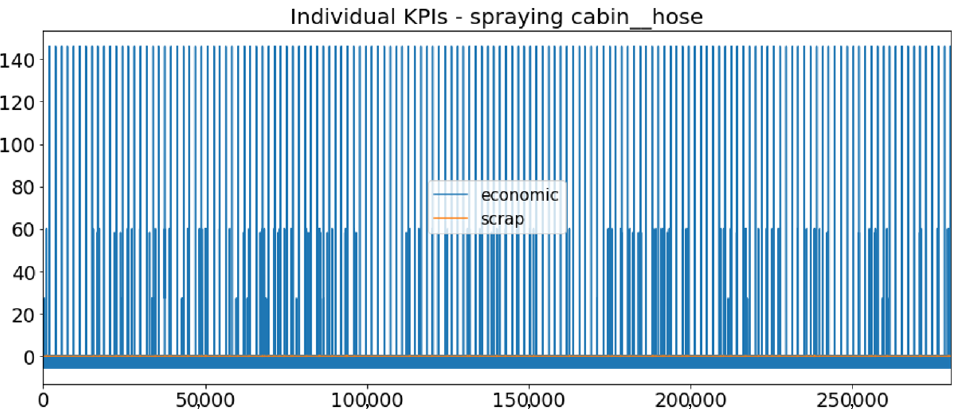
Figure 5. Individual KPI time series for the hose yielded from running the model for the spraying cabin (GORENJE). The simulation interval has a length of 8 years.